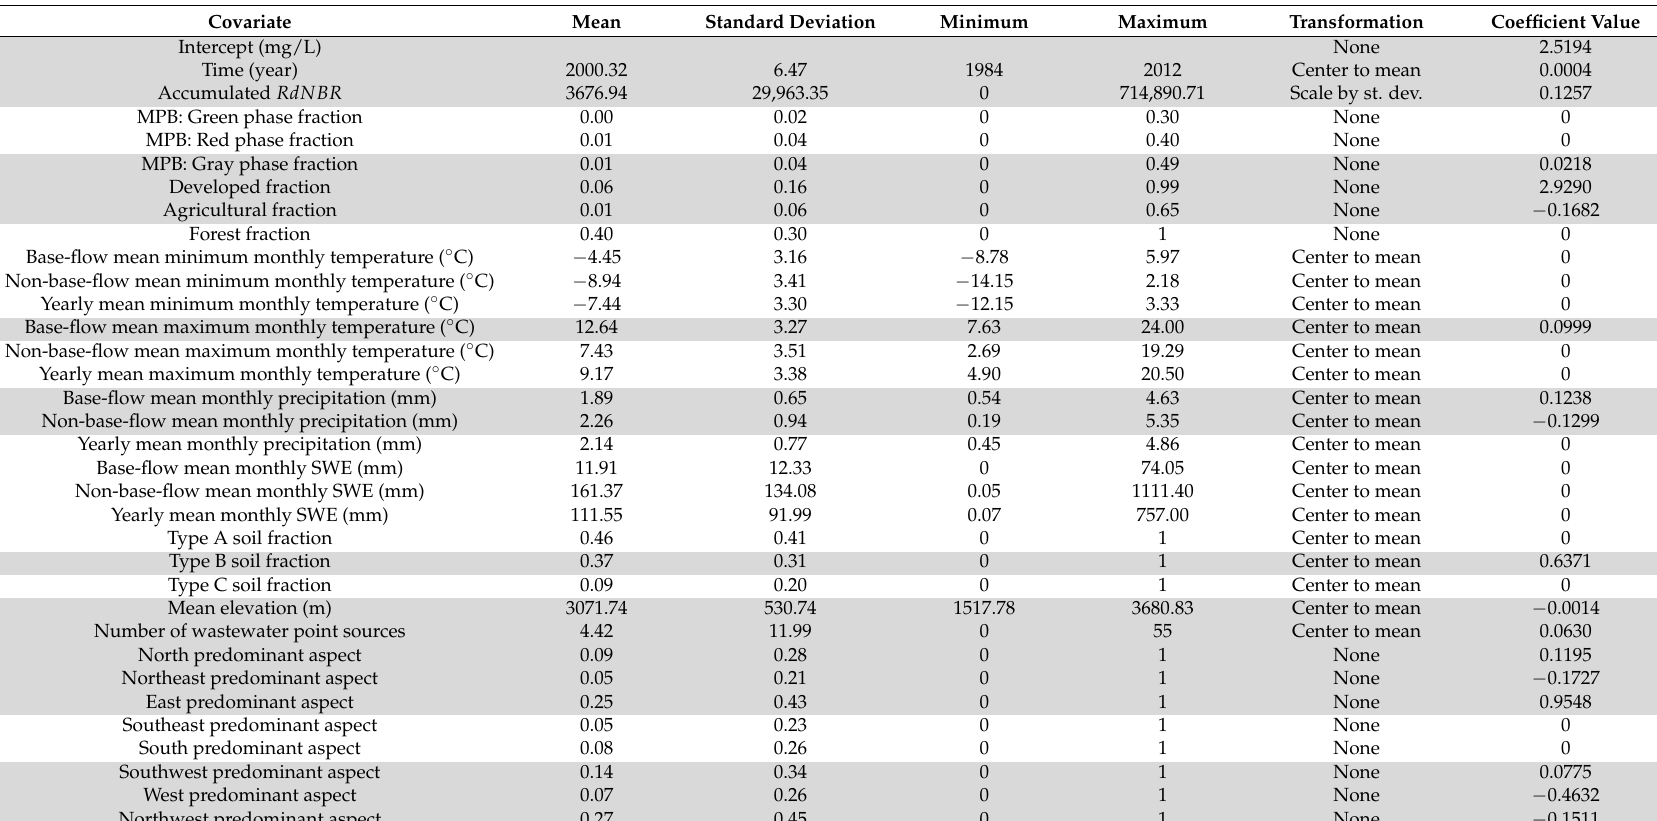
Table 2. Basic statistics, transformations, and LASSO coefficients when log ( λ ) = − 3 for all potential predictors. Basic statistics are reported for the untransformed features because the mean for the centered features would be zero, and the standard deviation for the scaled features would be one otherwise. The predictors with a coefficient significantly different from zero are highlighted. The accumulated RdNBR used corresponds to a decay of 90% in 5